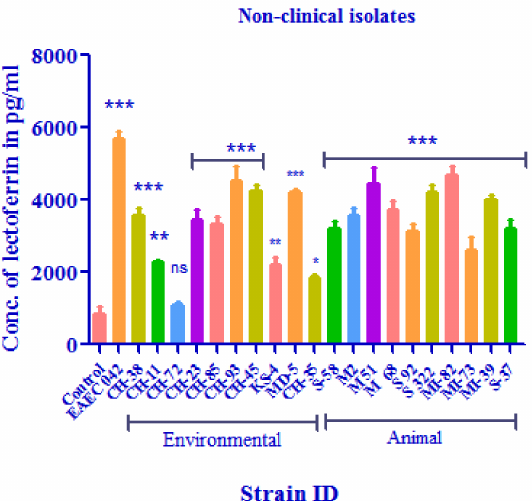
Figure 3. The concentration of lactoferrin (pg/mL) in BALB/c mice infected with the EAEC strain of environmental and animal origin. * p , 0.05; ** p , 0.01; *** p , 0.001; comparison by one-way ANOVA with Dunnett’s multiple comparison tests. NS = non-significant.